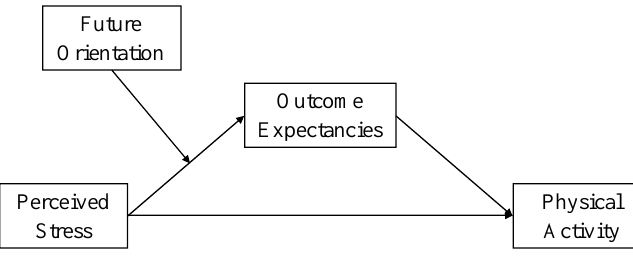
Figure 1. The present study.